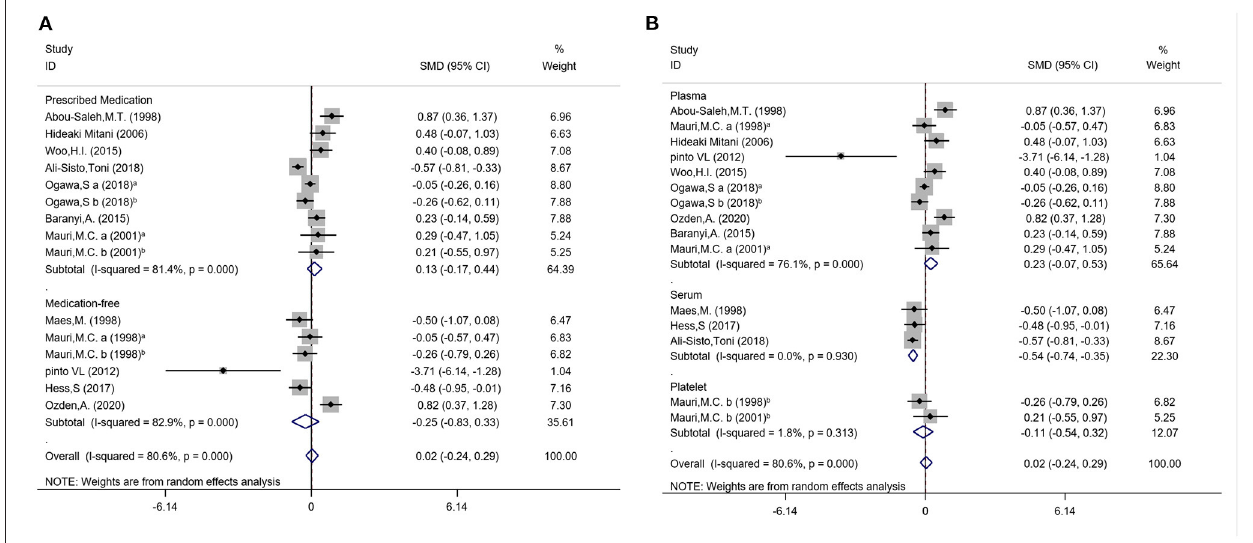
FIGURE 3 | Subgroup differences of the arginine concentrations in subjects with MDD and controls. (A) Medication status of arginine; (B) Sample types of